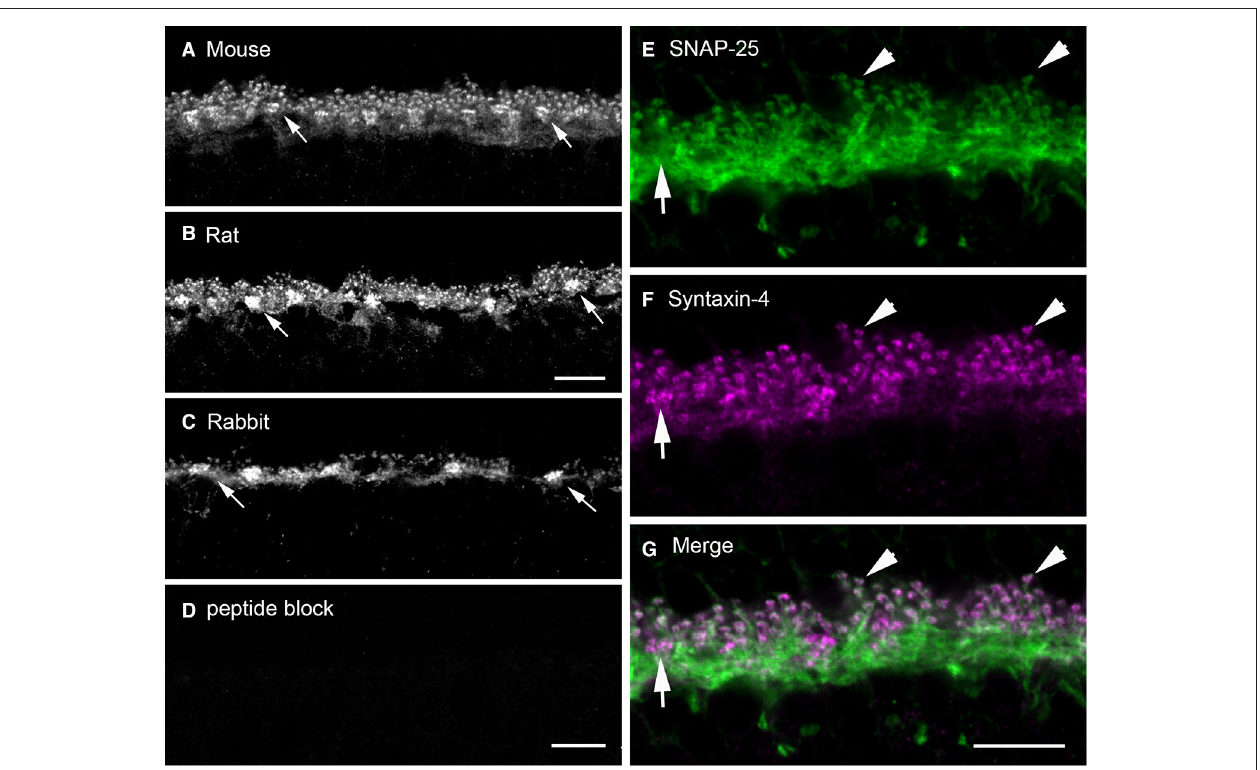
FIGURE 8 | Syntaxin-4 immunolabeling is present in the outer plexiform layer of mouse, rat, and rabbit retinas and colocalizes with that of SNAP-25. (A–C) Localization of syntaxin-4 immunoreactivity in vertical sections of (A) mouse, (B) rat, and (C) rabbit outer retina. Note the prominent immunoreactivity in the OPL of all three species. Arrows point toward thickenings or sandwiches of syntaxin-4 immunolabeling. (D) Pre-adsorption of the antibody with the antigenic peptide abolishes specific labeling in rabbit retina. (E–G) Syntaxin-4 (F) immunolabeling co-localized with that of SNAP-25 in horizontal cell processes and endings (E) as seen in the (G) merged image in mouse retina. Arrows point to horizontal cell dendritic contacts with cone pedicles. Arrowheads point to immunolabeling in horizontal cell axonal endings. (A,C,D) Maximum intensity projection of 3 images, z = 0.6 µ m. (B) Maximum intensity projection of 5 images, z = 0.46 µ m. (E–G) Maximum intensity projection of 3 images, z = 0.6 µ m. ONL, outer nuclear layer; OPL, outer plexiform layer; INL, inner nuclear layer. Scale bars, 10 µ m ( A,B in B , C,D in D , E–G in G ). (Modified from Hirano et al.,